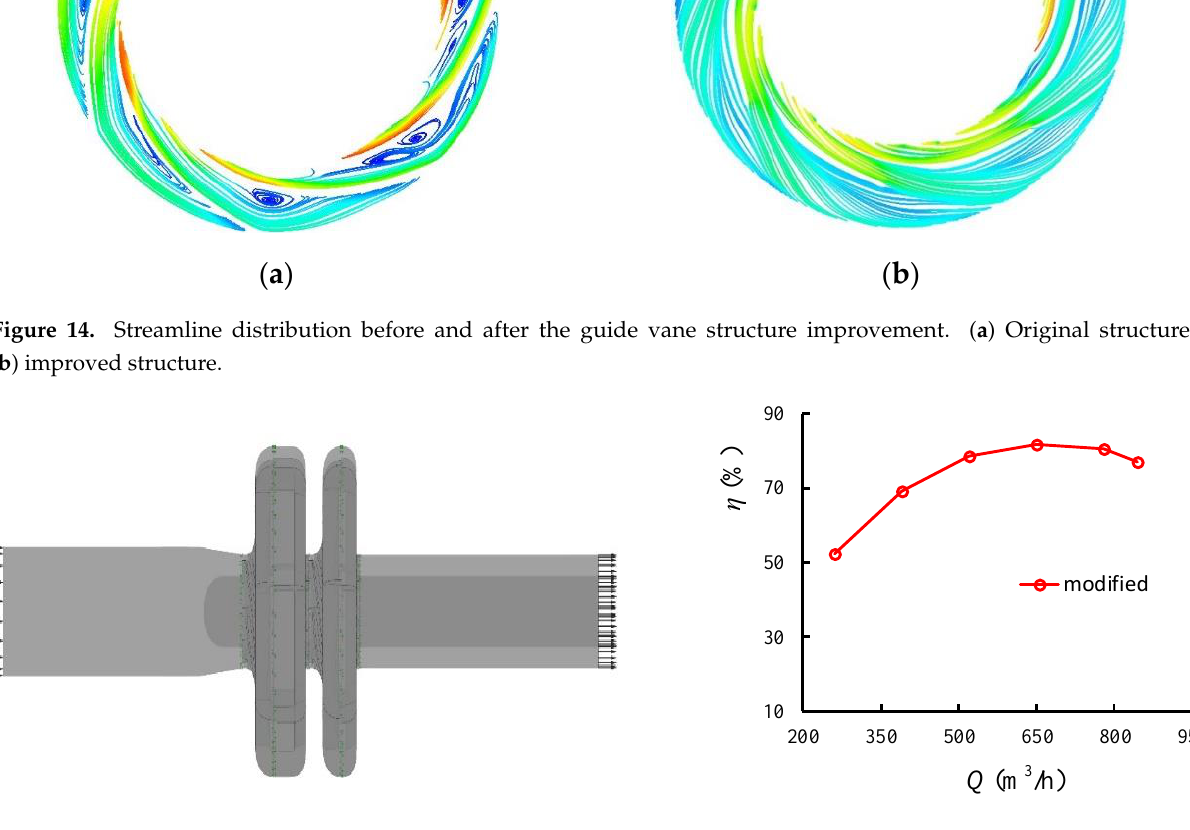
Figure 14. Streamline distribution before and after the guide vane structure improvement. ( a ) Original structure; ( b ) im- proved structure.